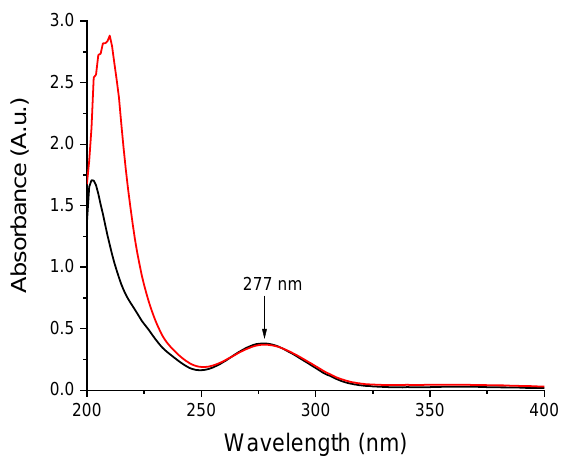
Figure 5. Comparative UV spectra recorded of ethanolic solutions of-red trace-the nanofibrous formulation (composition N2 of polymeric solution: 10 mg/g aceclofenac, 15 w / w % PVP, 1 w / w % trolamine in ethanol:water 75:25 w / w %); black trace – neat aceclofenac.